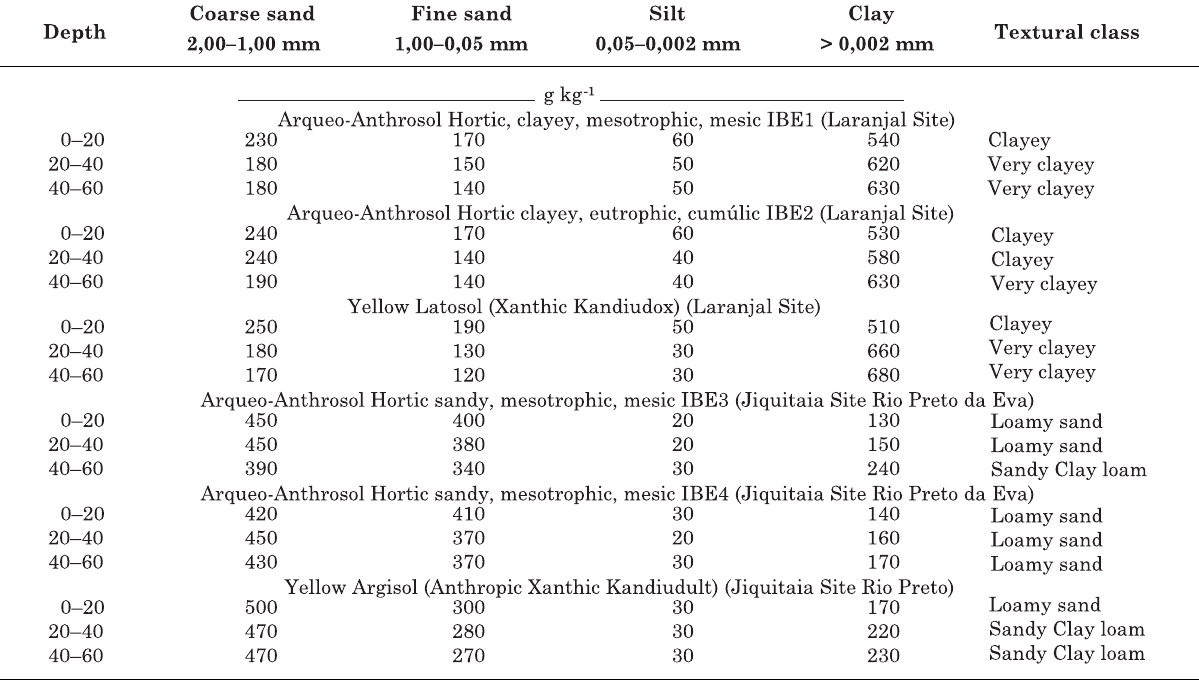
Table 1. Textural characteristics of IBE soils